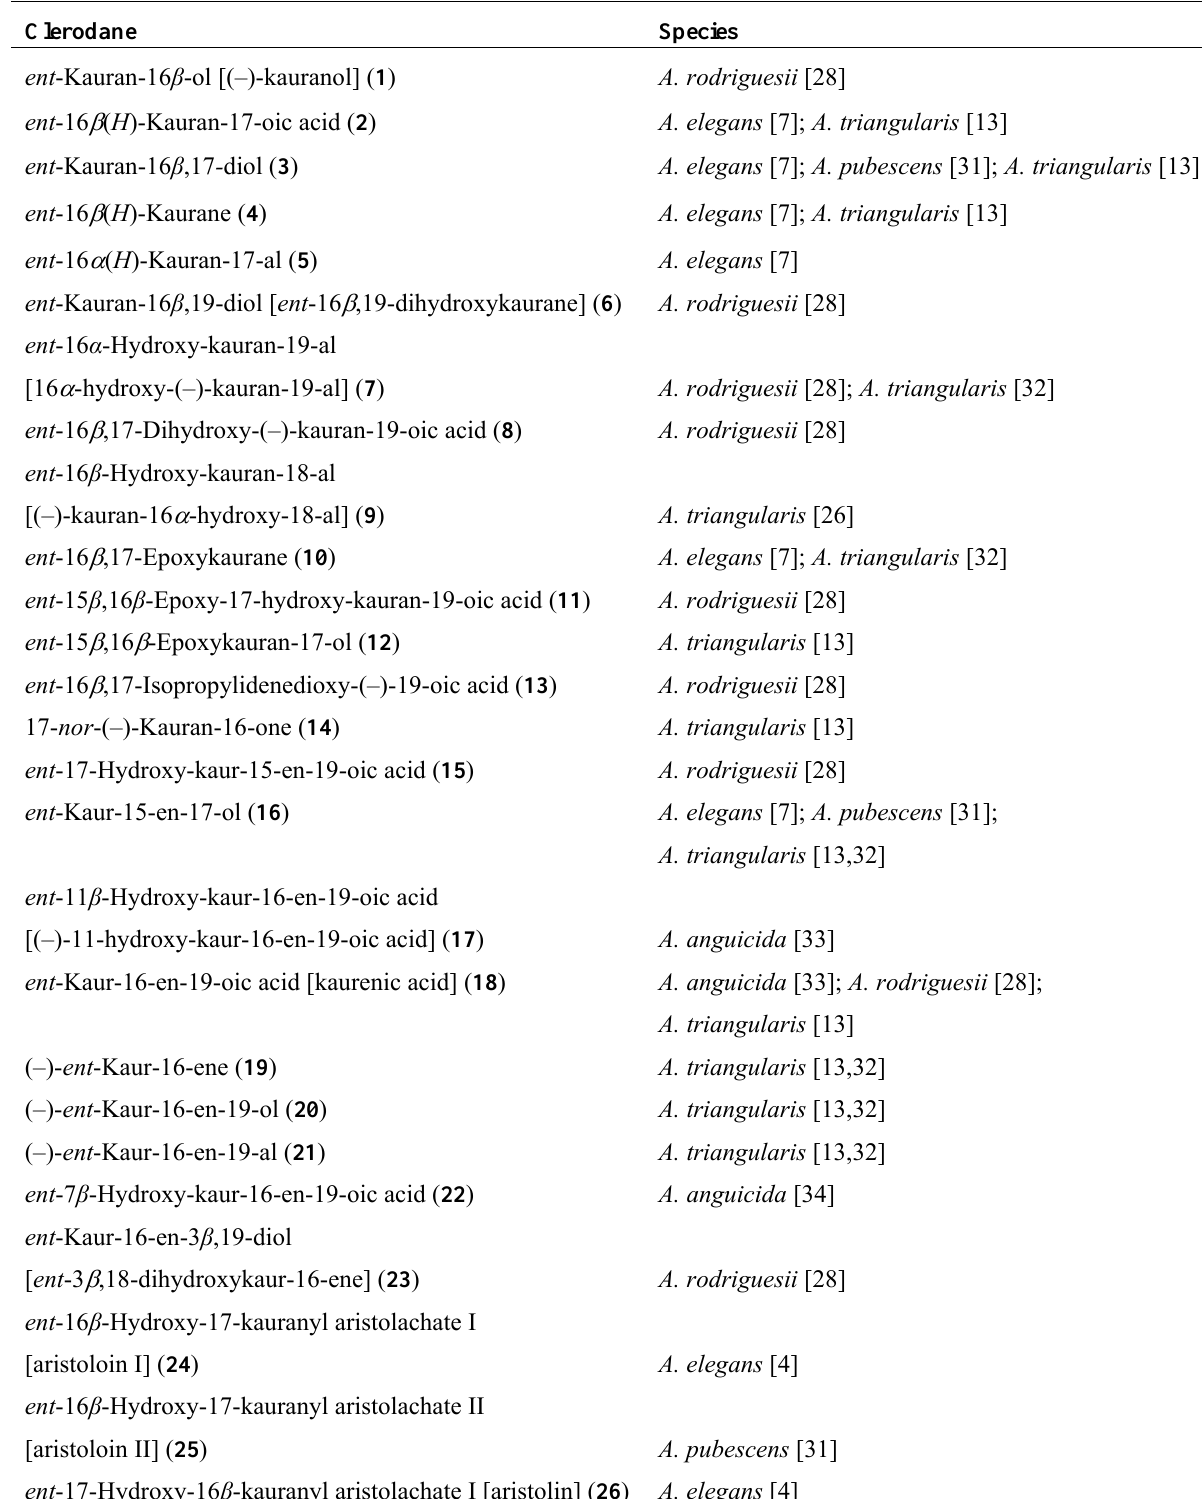
Table 1. Kaurane diterpenoids isolated from Aristolochia